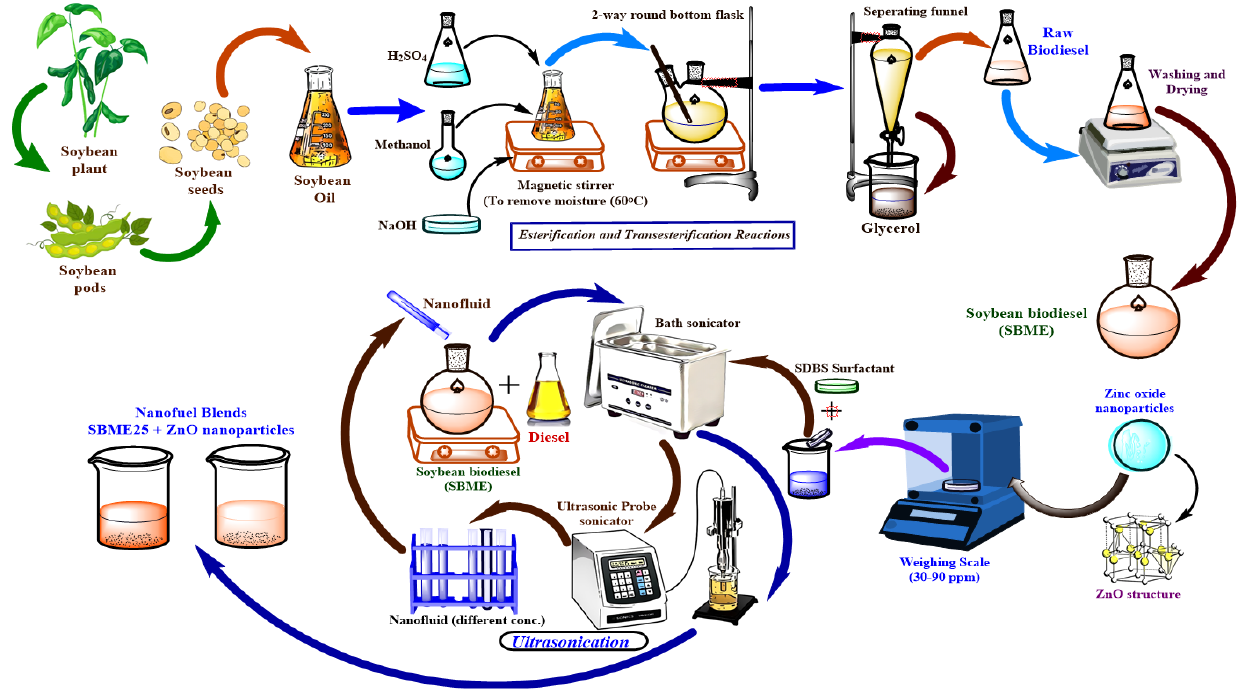
Figure 1. Comprehensive steps involved in the production of nano fuel blends [20].